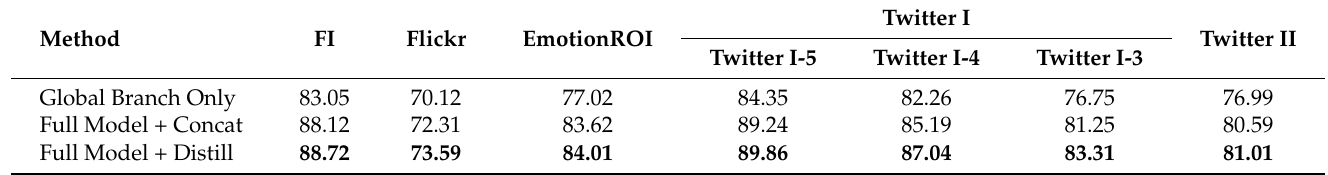
Table 2. The model performance comparison across image